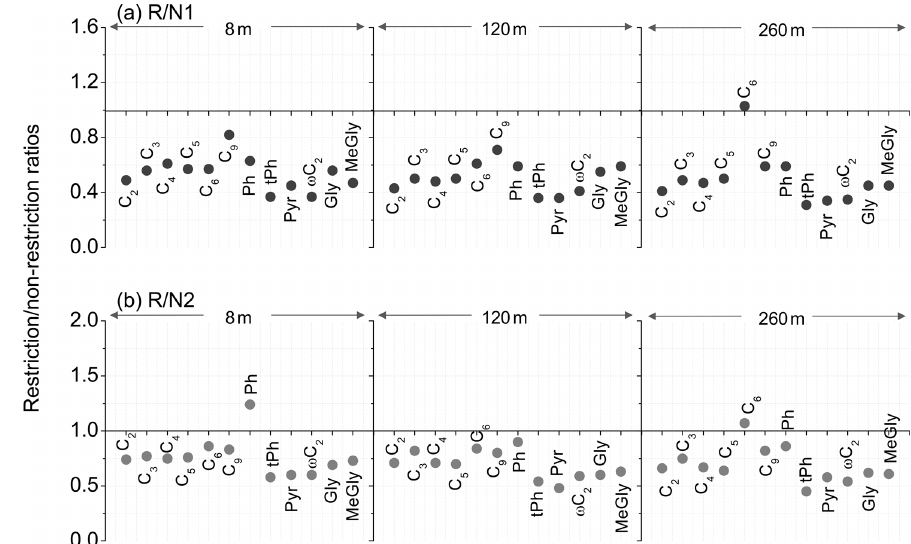
Figure 6. The R/N ratios of diacids and related compounds observed at the tower in Beijing in summer 2015.